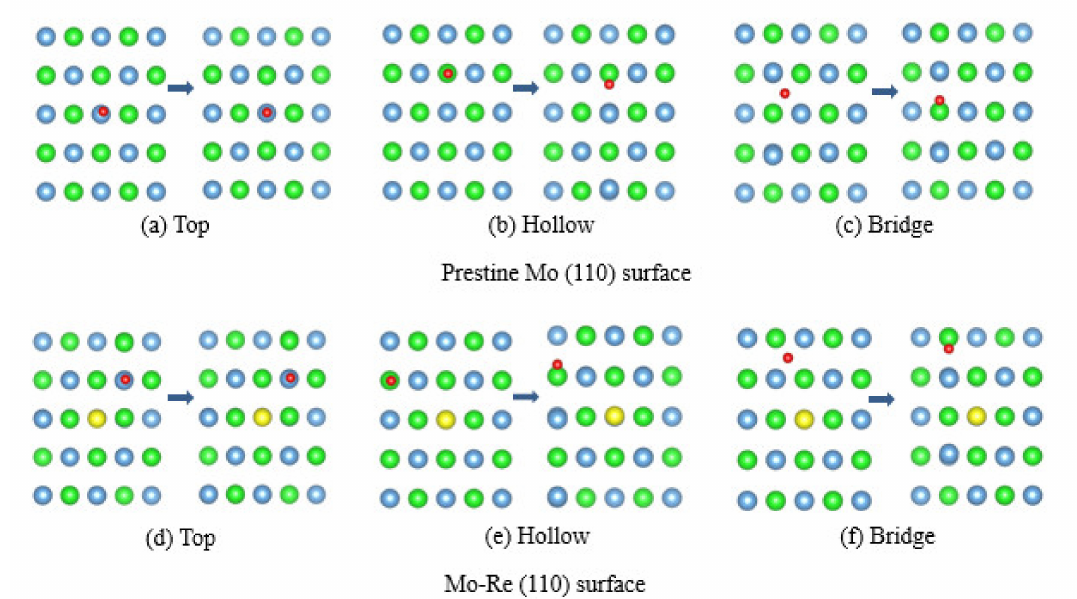
Figure 5. Initial and final configurations of O adsorption on Mo (110) and Mo-Re (110) surfaces. Scheme 110. surface. Snaps ( a – c ) show O atoms initially placed at Top site, Hollow site and Bridge site of Mo (110) surface, while snaps ( d – f ) show O atoms initially placed at Top site, Hollow site and Bridge site of Mo-Re (110) surface. Blue and green spheres represent Mo atoms in the first layer and the second layer. Yellow and red spheres represent Re atoms and O atoms,